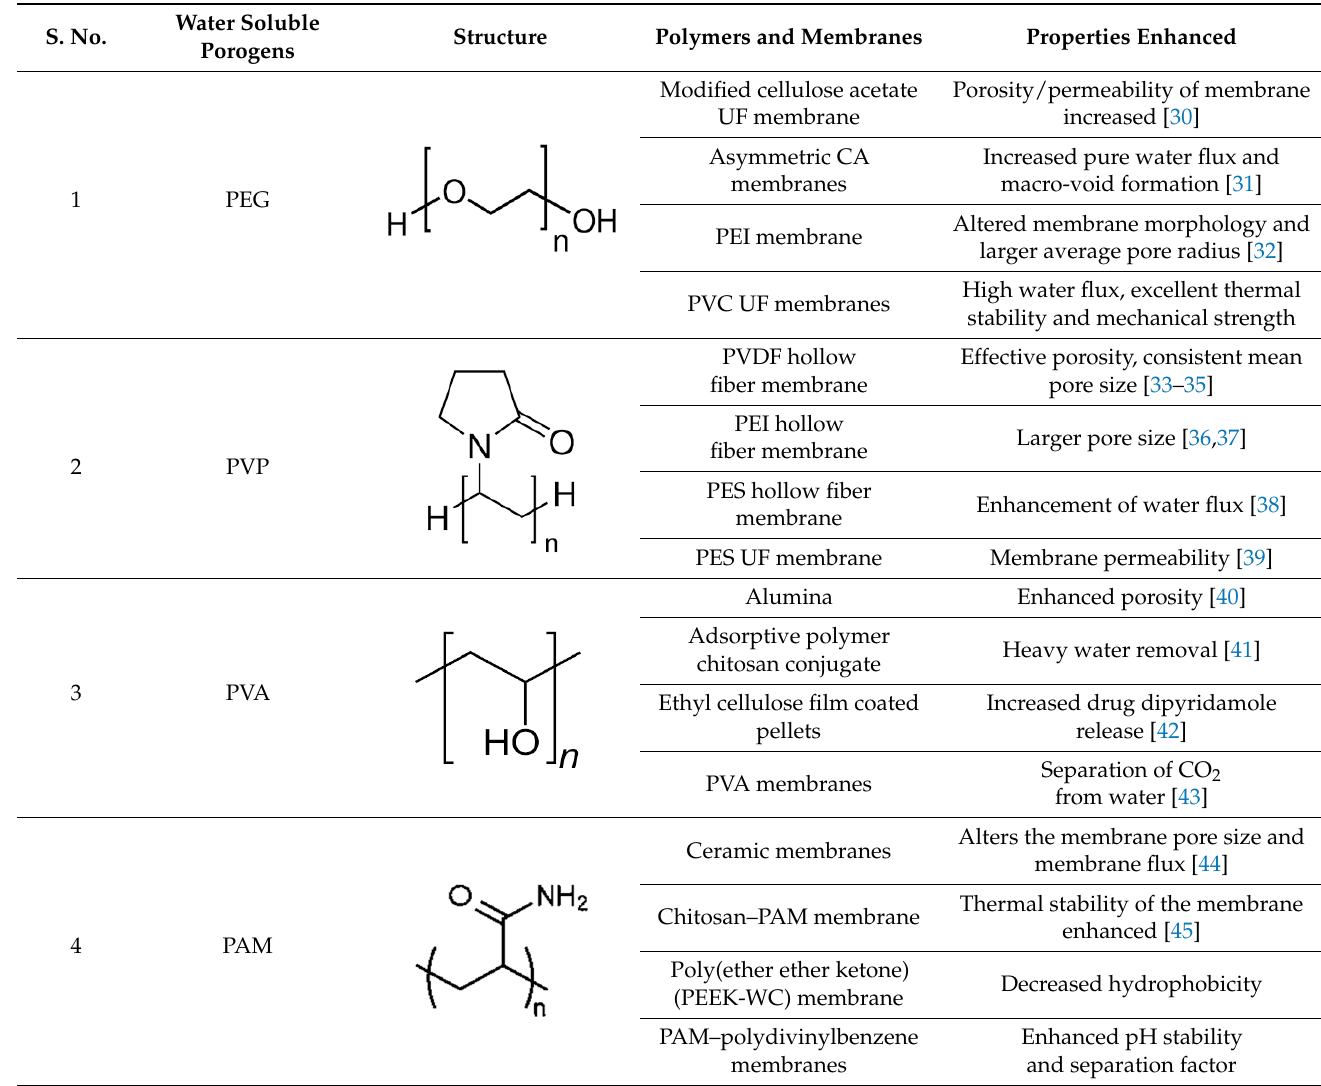
Table 4. Different water-soluble porogens used in ultrafiltration (UF) membranes.